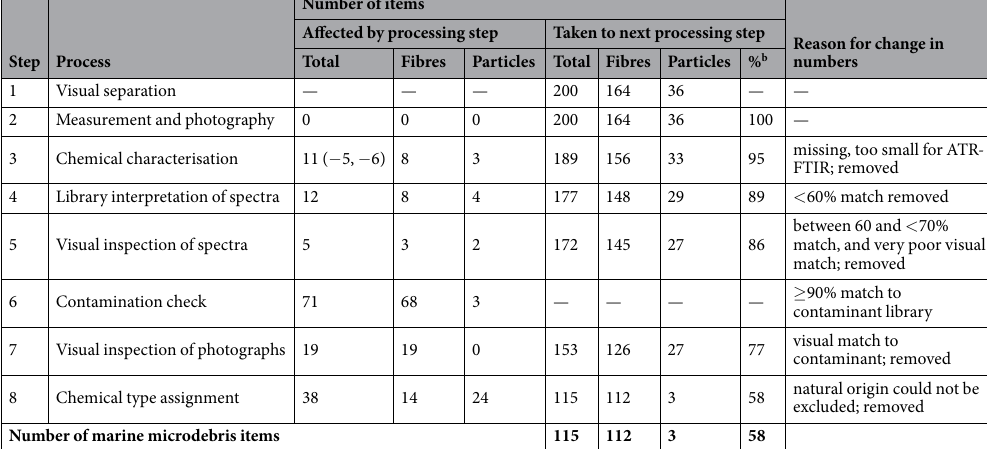
Table 2. Application of analysis workflow to fish gastrointestinal tract contents 20 . The workflow is tailored to quantifying microdebris contamination, and applied to the gastrointestinal tract contents of 20 similarly-sized juvenile coral trout ( Plectropomus leopardus and P. maculatus ) collected on reefs around four reef islands in the Great Barrier Reef World Heritage Area, Australia, in 2011. The number of items affected by and taken to the next processing step of the analysis workflow, and the reason for a reduction in numbers is given; b percentage based on total items separated using visual examination (n =